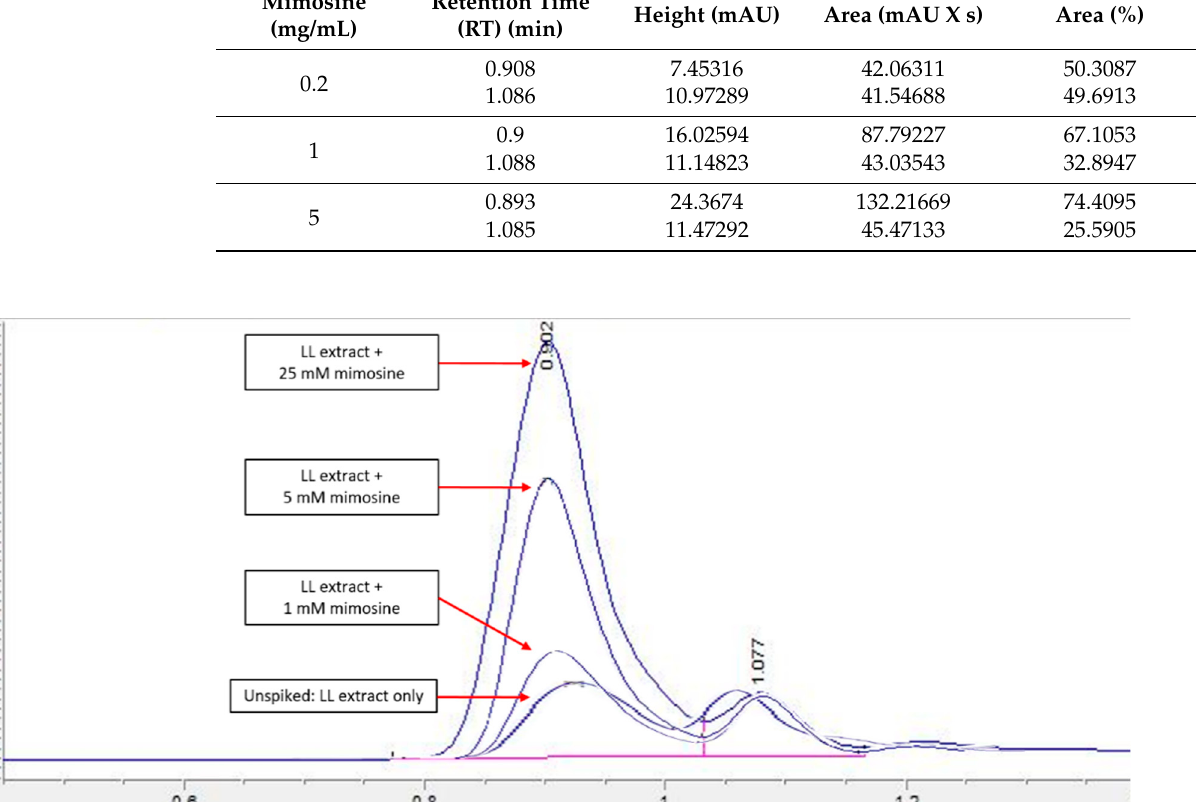
Table 1. HPLC report for mimosine.